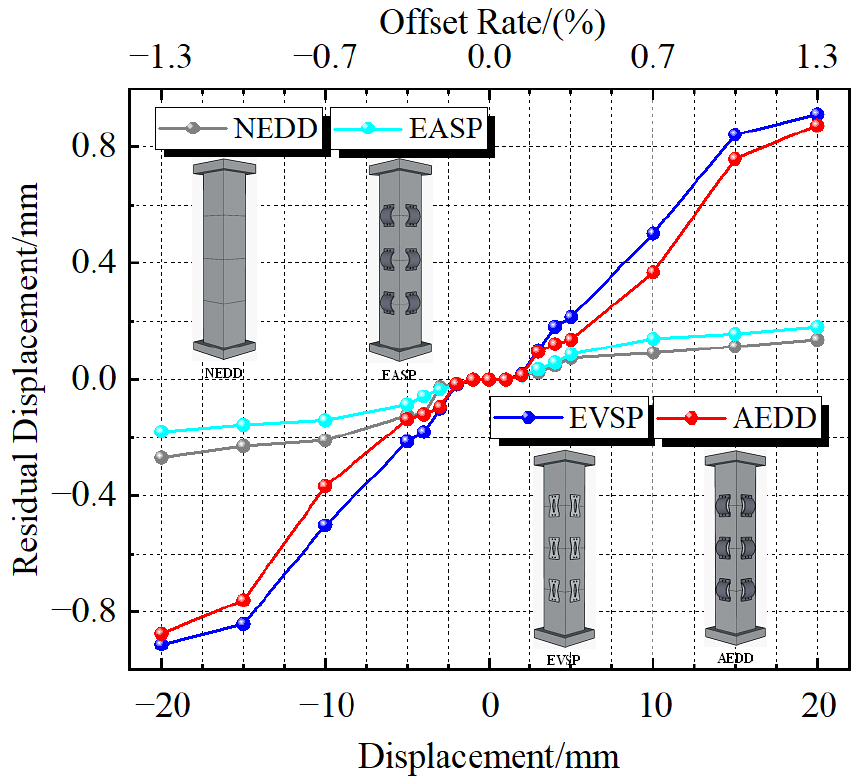
Figure 16. Residual displacement change curves of different forms of piers.